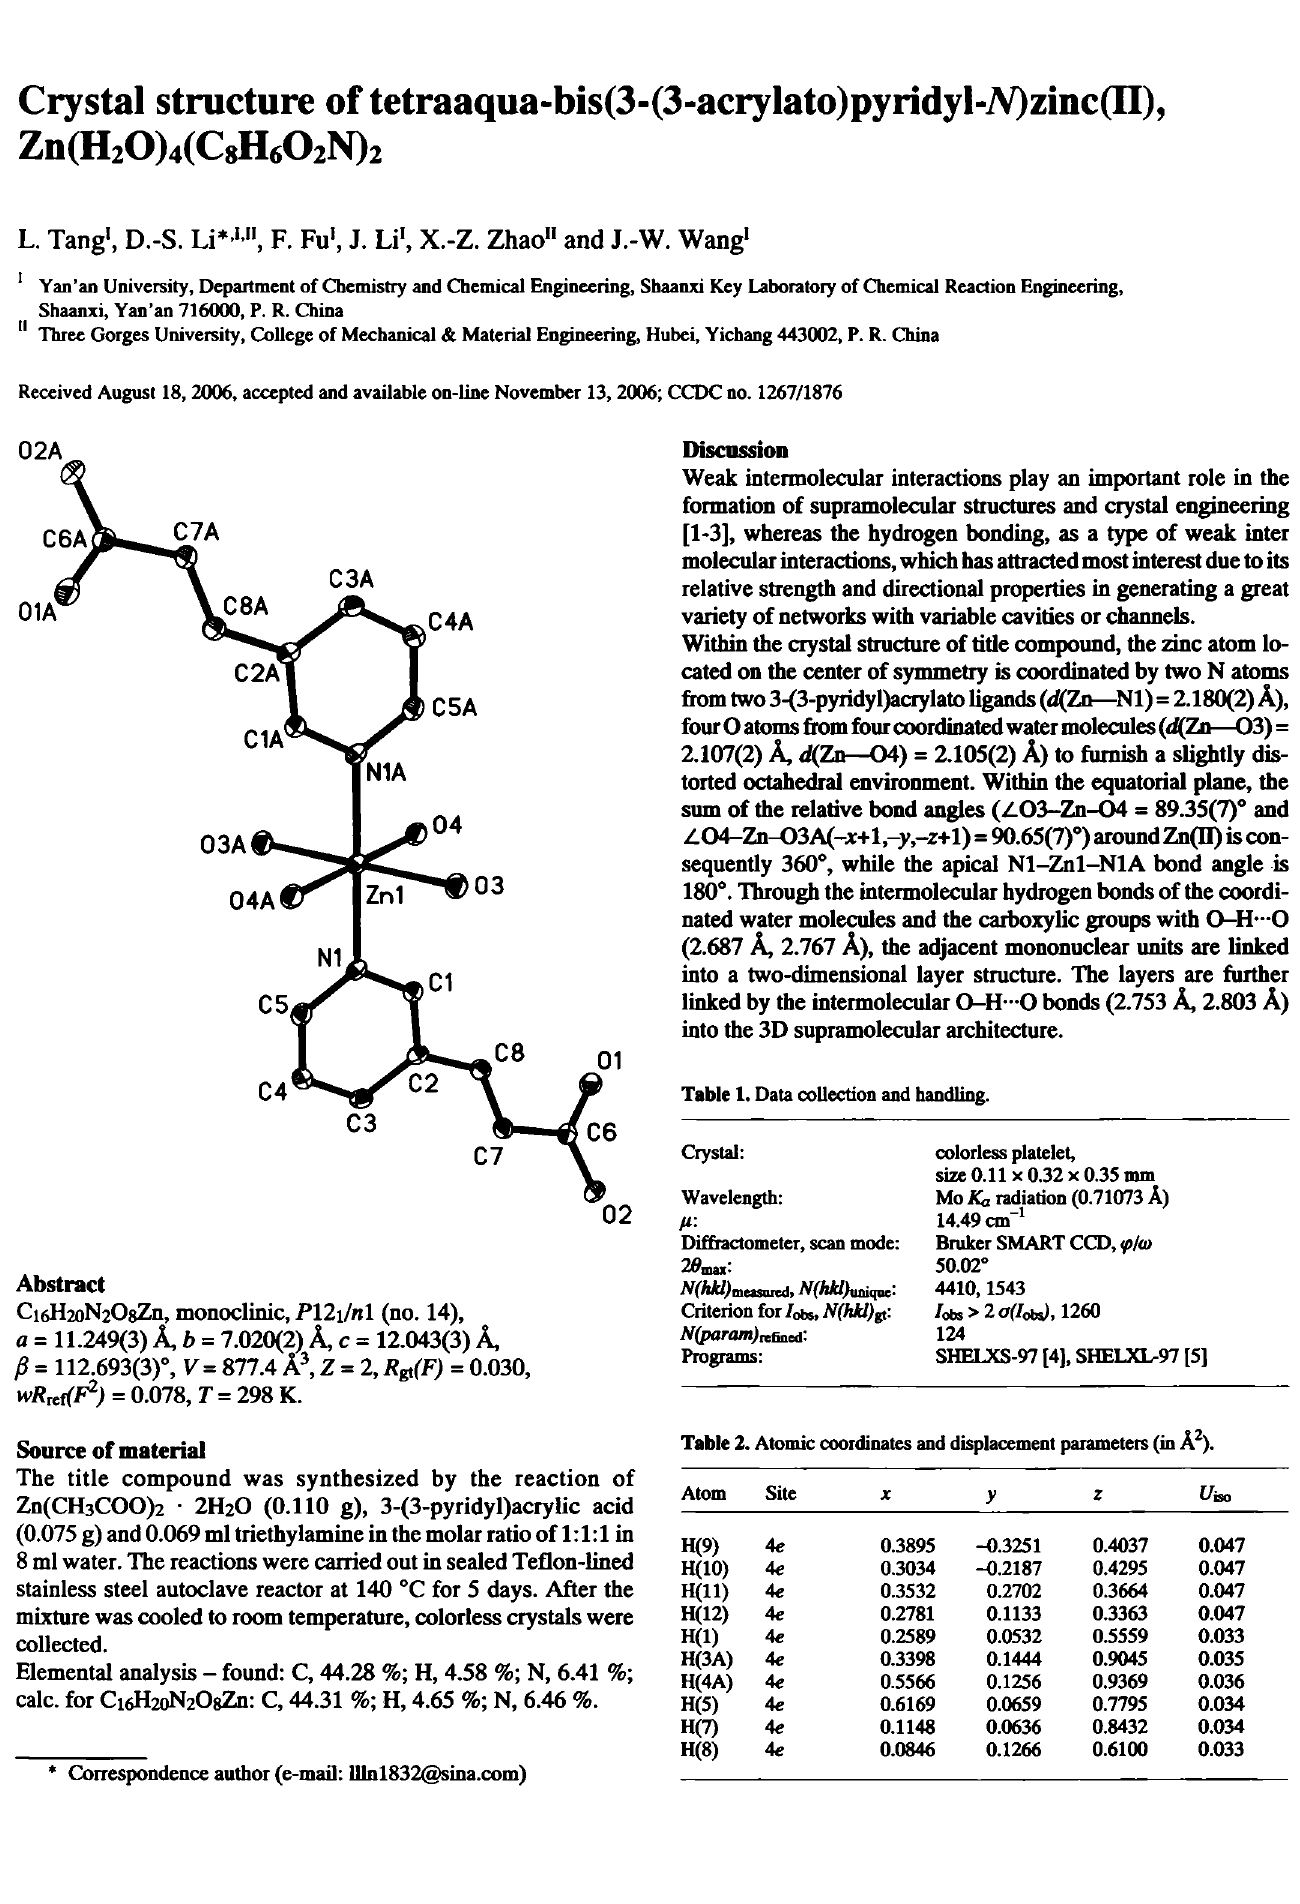
Table 2. Atomic coordinates and displacement parameters (in Ä 2